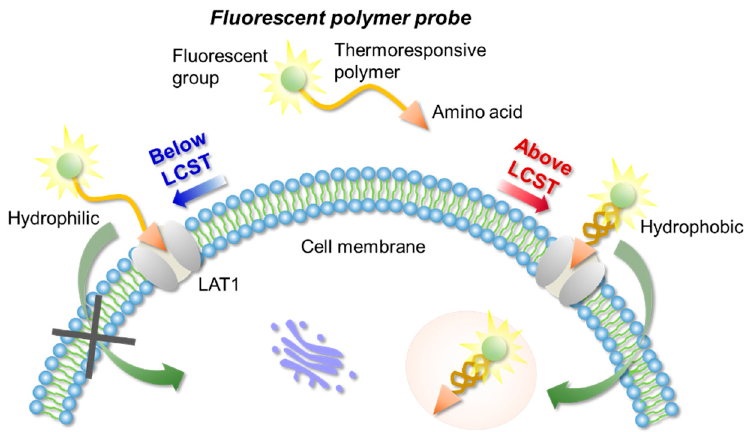
Figure 1. The concept of LAT1-targeting thermoresponsive fluorescent polymer probes.